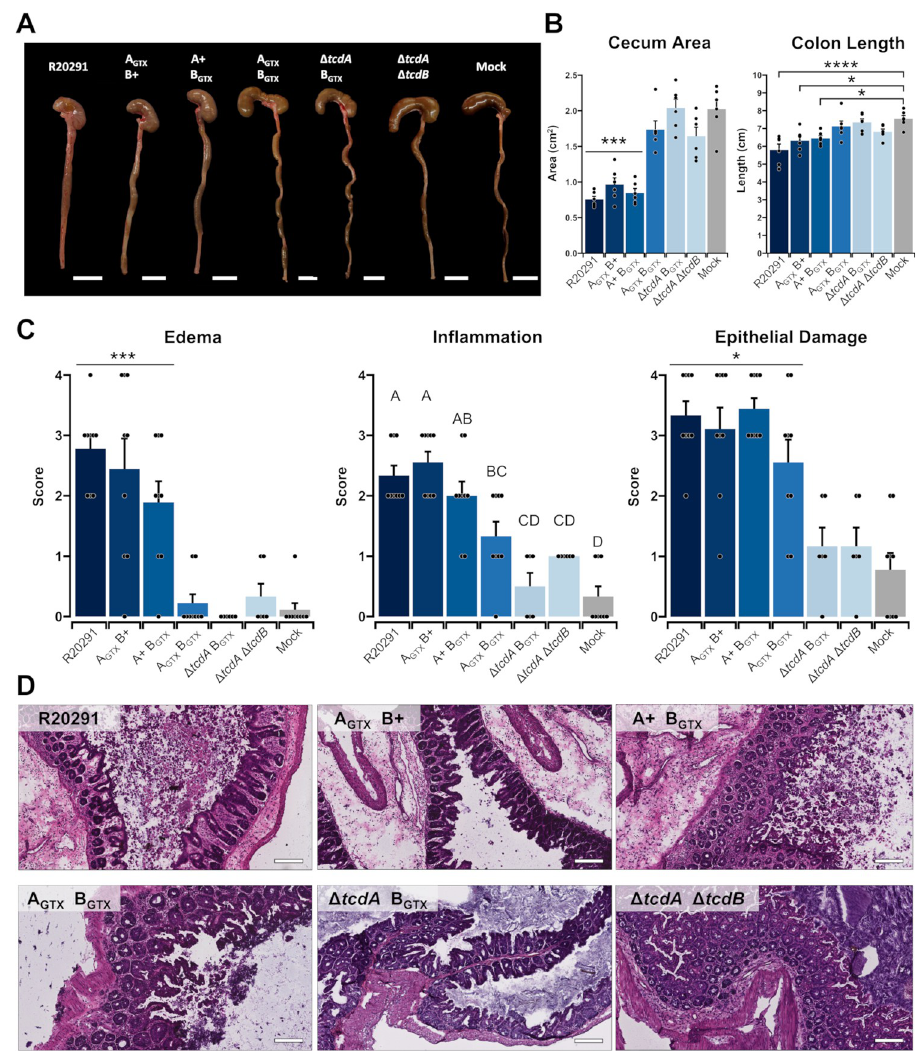
Fig 3. Glucosyltransferase activity causes edema and inflammation, but epithelial damage is glucosyltransferase independent. (A) Representative images of ceca and colons from mice inoculated with each treatment at 2 dpi. White bars denote 1 cm. (B) Cecum area and colon length as metrics of organ inflammation. Bars are the mean of each group and points are individuals within the group. Error bars represent standard error of the mean. Differences in cecum area depict that R20291, A GTX B+, and A+ B GTX are significantly smaller than the four other groups. Differences in colon length are comparing R20291, A GTX B+, and A+ B GTX to mock-inoculated colons. (C) Epithelial damage, inflammation, and edema mean scores as determined by a gastrointestinal pathologist. Points represent each individual animal and error bars are the standard error of the mean ( n = 6–9 per treatment). Statistical differences as determined by Tukey’s HSD are shown in brackets ( � p < 0.05; ��� p < 0.001; ���� p < 0.0001) or by letters ( p < 0.05). (D) Representative H&E images of mouse ceca inoculated with each strain at 2 dpi. Scale bar, 80 μ